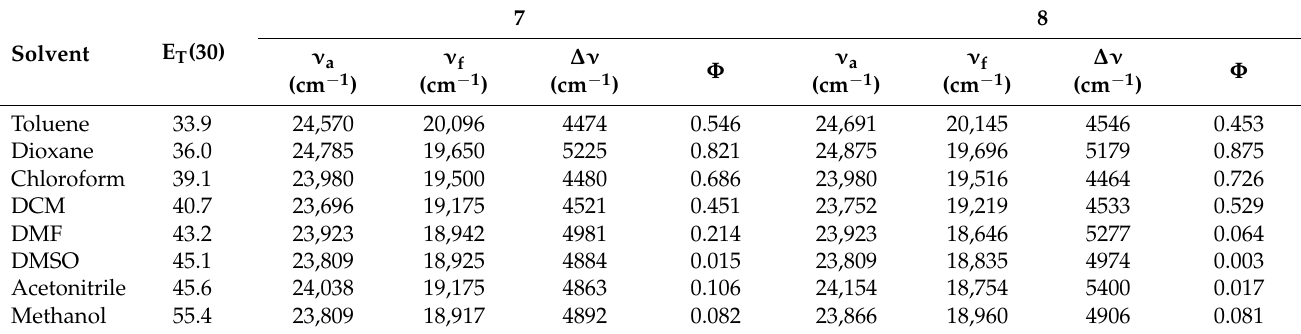
Table 1. Optical properties of piperidine-naphthalimide derivatives in different solvents.